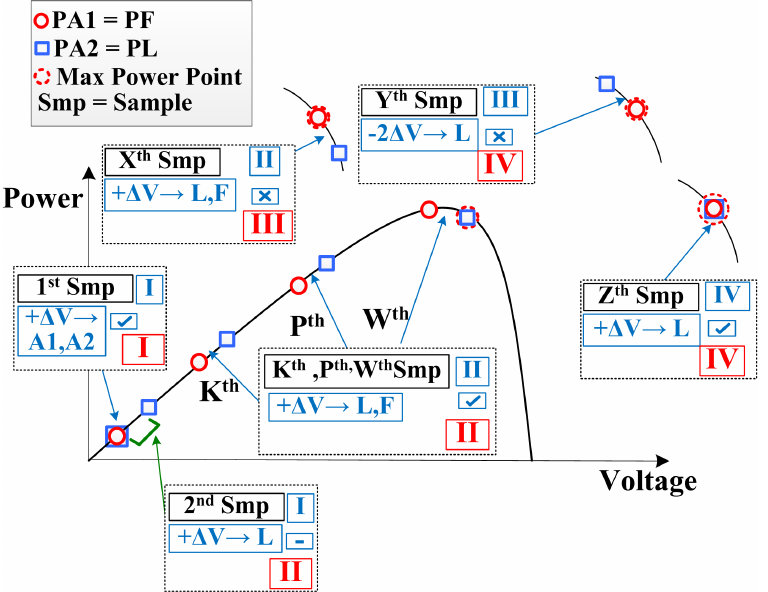
Figure 6. Scenario 1: Graphical analysis of proposed technique under uniform irradiance